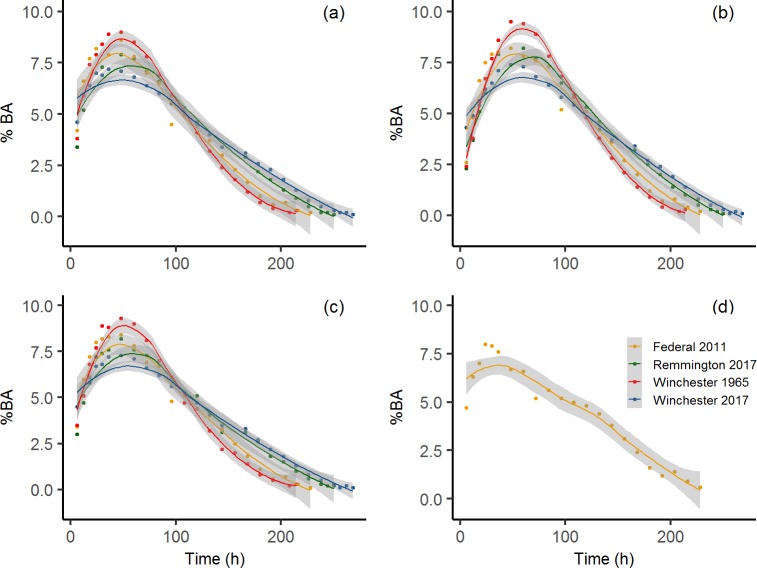
Average percent bioaccessibility of As, Sn, Sb, and Pb for each shot type at all time points analyzed.(a) Pb, (b) Sb, (c) As, and (d) Sn. Tin (d) is only included for Federal (2011) as Sn was < DL for all other shot types and bioaccessibility calculations could not be performed. Solid line represents the line of best fit along and shaded areas are the 95% confidence interval (n = 6 for Federal shot, n = 3 for all other shot types).